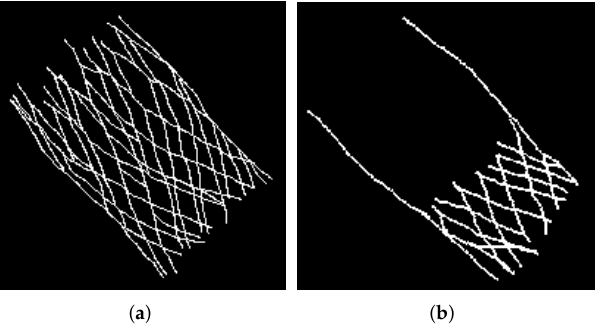
Figure 3. Cropped versions, only the region where the THV is contained, of the gold standard of different frame types. ( a ) Fully expanded THV. ( b ) Contrast